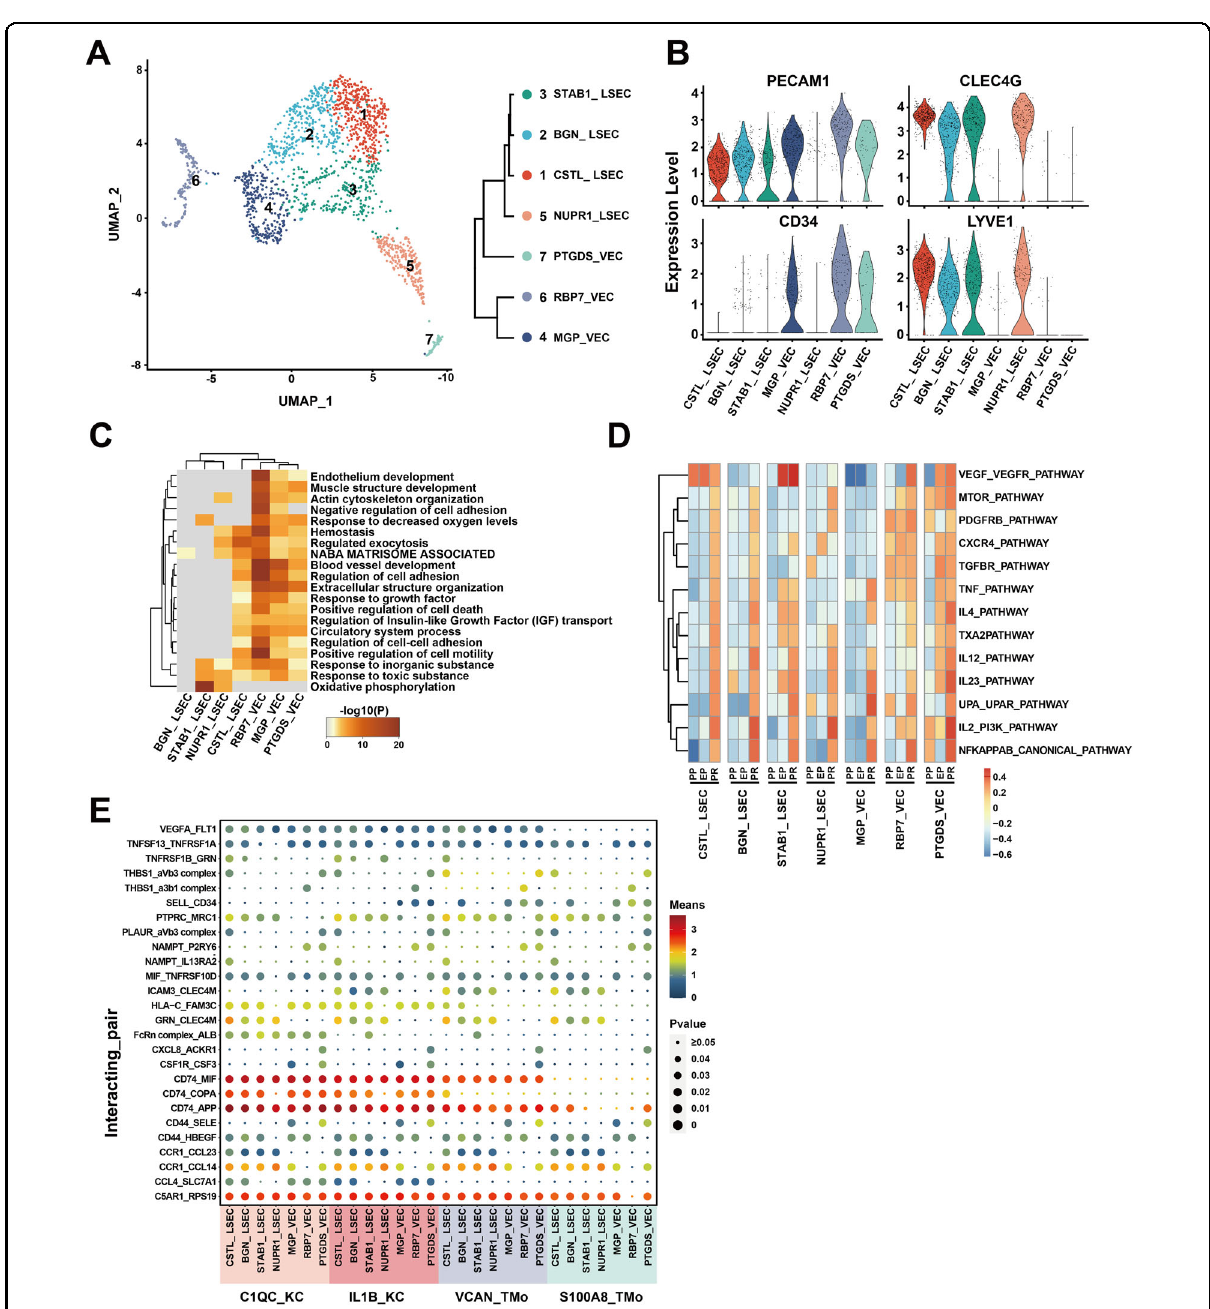
Fig. 4 scRNA-seq of endothelial cells in liver transplantation. A UMAP plot showing seven endothelial cell clusters in liver transplantation, colored according to different clusters (left panel). Dendrogram of seven clusters by hierarchical clustering analysis based on their normalized mean expression values (right panel). B Violin plots showing the normalized expression of PECAM1 , CLEC4G , CD34 , and LYVE1 genes ( y -axis) for endothelial cell clusters ( x -axis). C Gene Ontology enrichment analysis results of endothelial cell clusters. Only the top 20 most signi fi cant GO terms ( p value < 0.05) are shown in rows. D GSVA showing the pathways (PID gene sets) with signi fi cantly different activation in different samples of endothelial cell clusters. Different colors represent different activation scores. E Cell – cell interaction analysis between mononuclear phagocyte clusters and different endothelial cell clusters in PR samples. Ligand – receptor pairs are labeled in y -axis. The size of the circle represents the level of p value while different colors represent different means value. Ligands come from mononuclear phagocyte clusters, and receptors come from endothelial cell